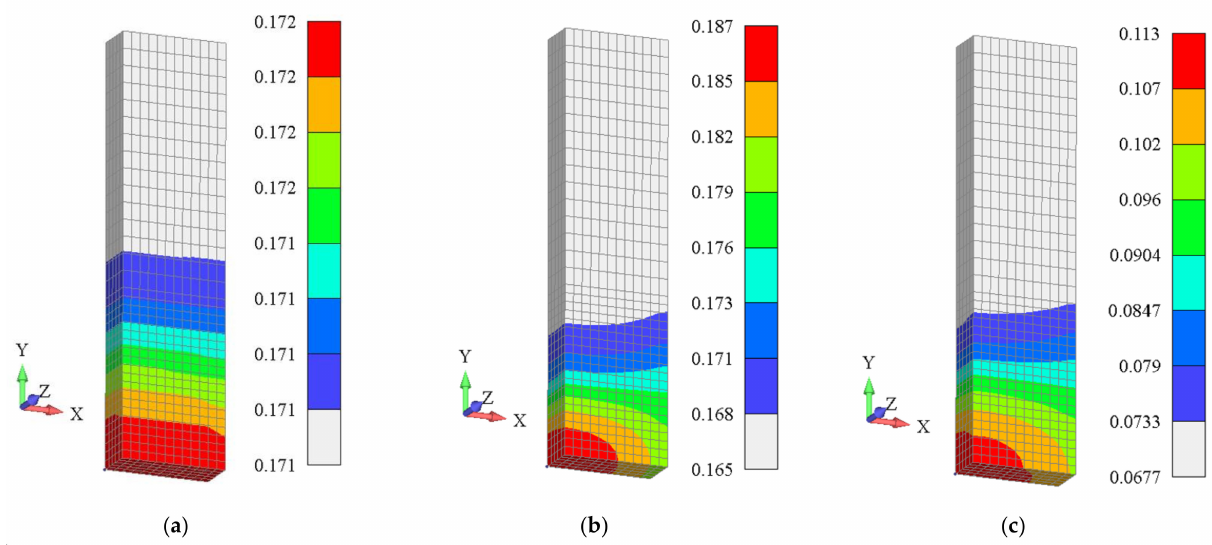
Figure 6. FEM simulation results for AA5083-H111: ( a ) Effective plastic strain field, plasticity; ( b ) Effective plastic strain field, phase-field and plasticity; and ( c ) damage field, phase-field and